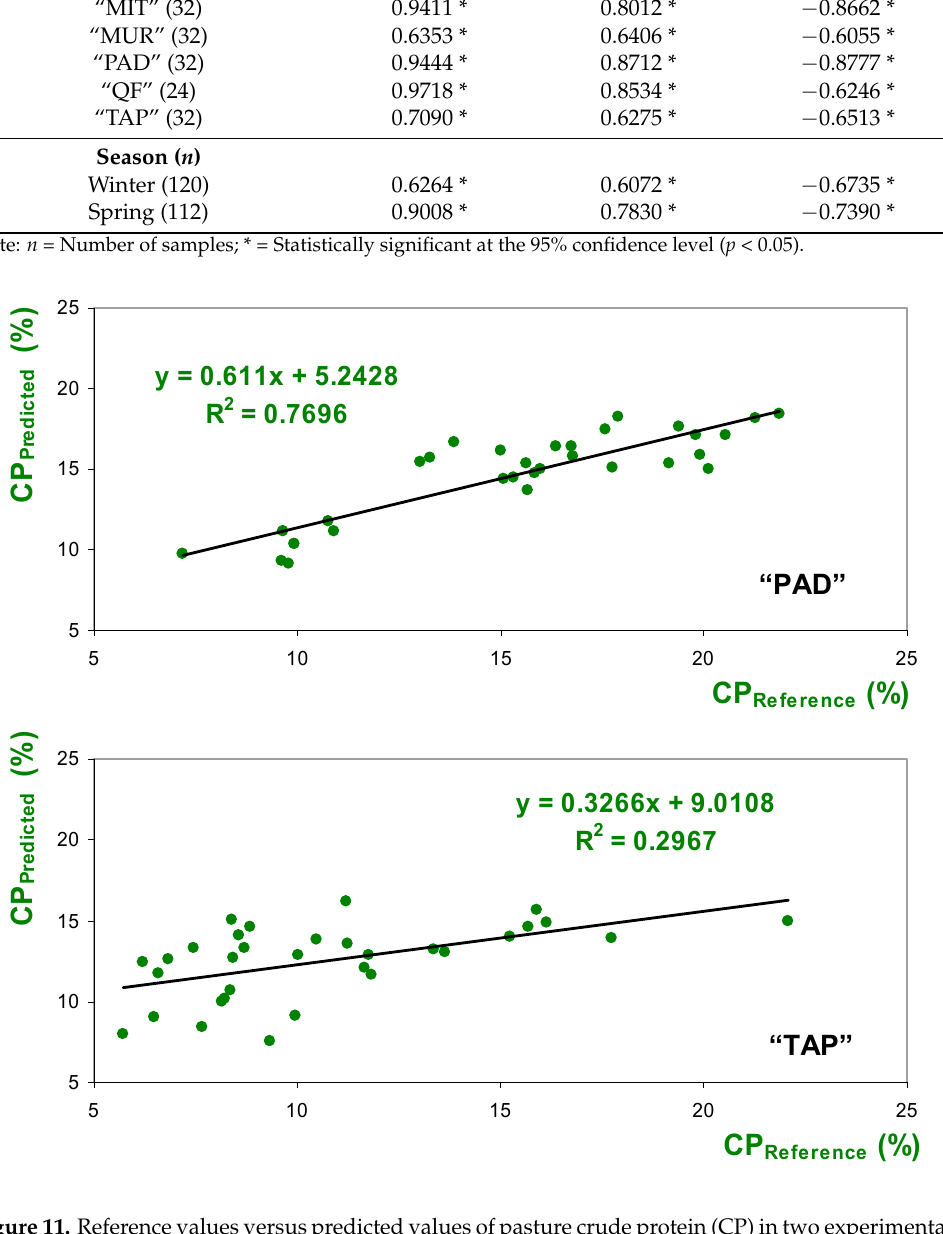
Figure 11. Reference values versus predicted values of pasture crude protein (CP) in two experimental fields (“PAD” and “TAP”).